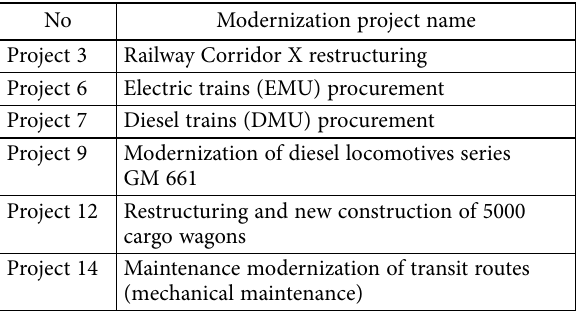
Table 2. Modernization project selected as portfolio